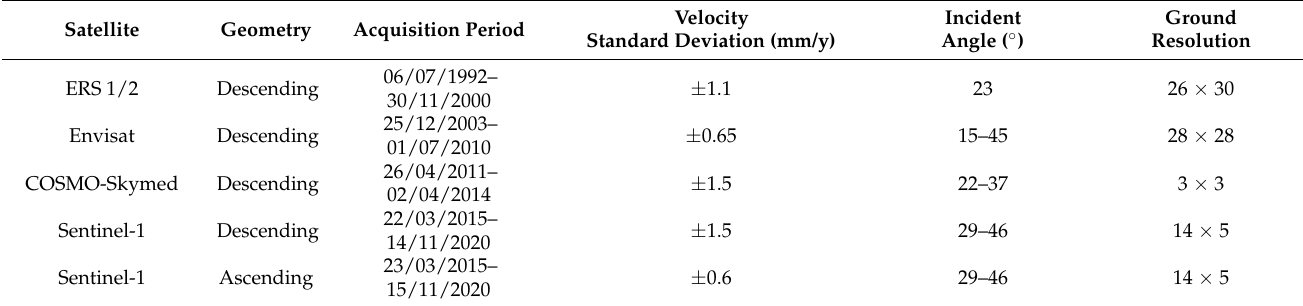
Table 1. PSI dataset used for the characterization and monitoring of the Pariana landslide.